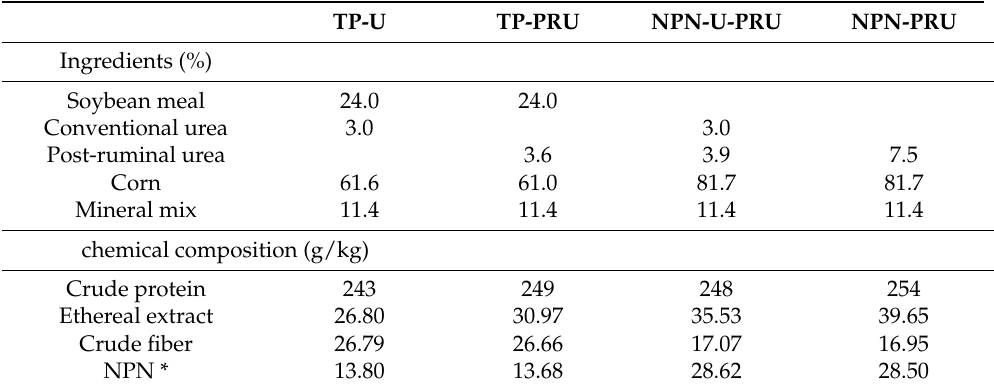
Table 1. Composition of the supplement used during the experimental